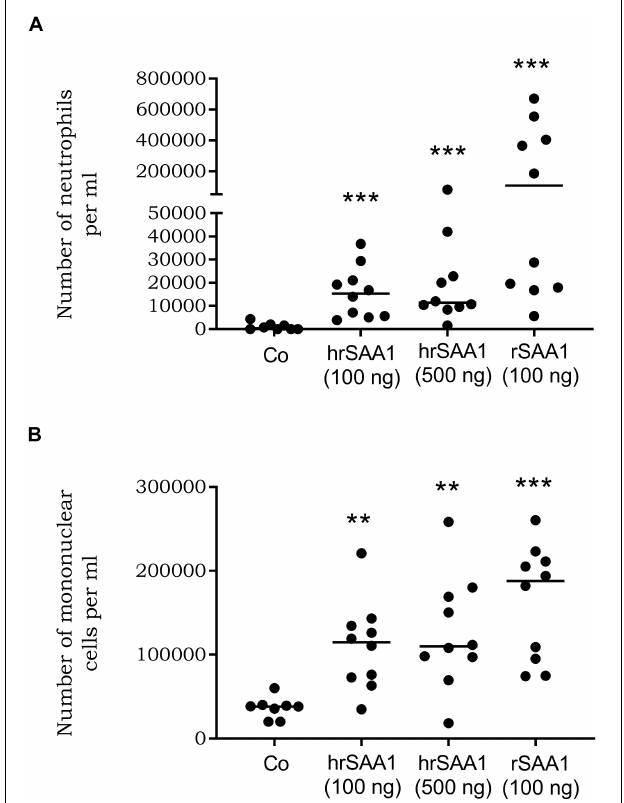
FIGURE 8 | hrSAA1 induces in vivo recruitment of neutrophils and mononuclear cells. C57BL/6J male mice (8–10 mice per group) were intra-articularly injected with homogenous rSAA1 (hrSAA1; 100 or 500 ng/10 µ l), rSAA1 (100 ng/10 µ l) or 0.9% sodium chloride (control; 10 µ l). Following an incubation period of 3 h, cells from the joint were collected and cytospins were prepared. Each dot represents one mouse and the horizontal line indicates the median number of recruited (A) neutrophils and (B) mononuclear cells per ml. Data are derived from two independent experiments. Significant leukocyte recruitment in comparison to control is indicated by asterisks (Mann-Whitney U -test; ** p -value < 0.01, *** p -value <